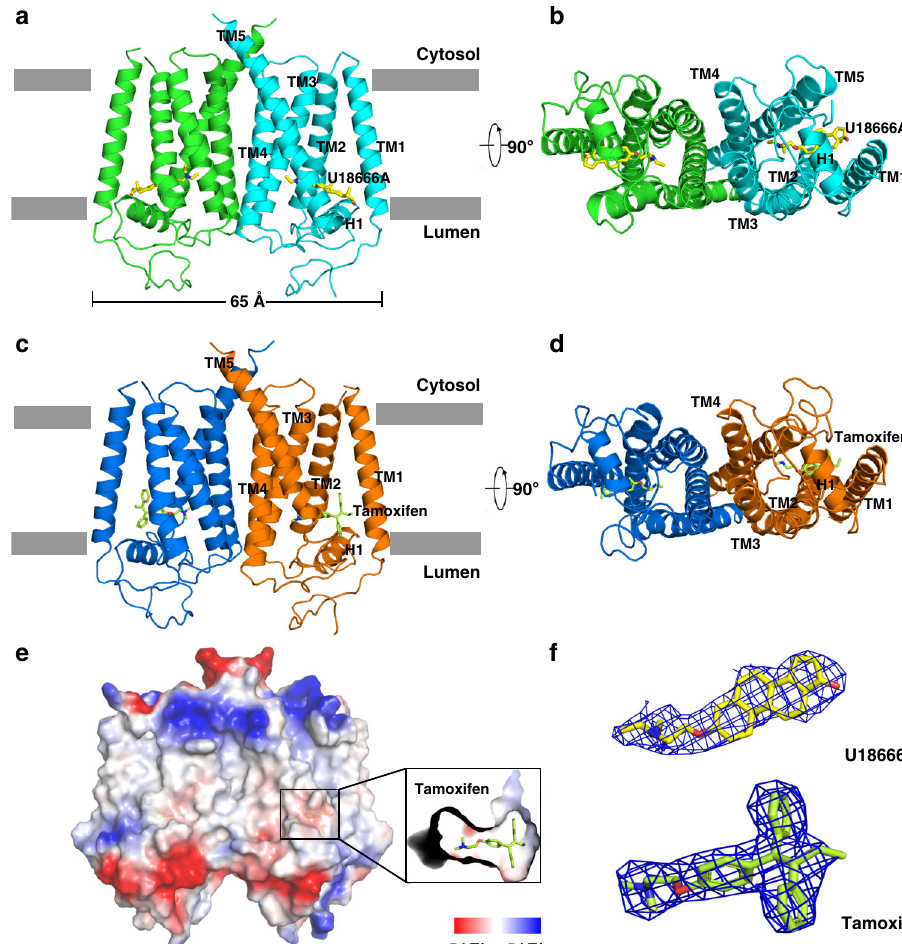
Fig. 2 Molecular architecture of human EBP. a Overall structure of EBP with U18666A viewed parallel to the membrane. Each molecule of the dimer is indicated in the different colors. The two lines show the approximate location of the lipid bilayer. b The bottom view of EBP with U18666A from the lumen. c Overall structure of EBP with tamoxifen viewed parallel to the membrane. d The bottom view of EBP with tamoxifen from the lumen. e Electrostatic surface representation of EBP and the ligand-biding site with tamoxifen. f , 2Fo – Fc map for U18666A and tamoxifen (blue mesh) contoured at 1